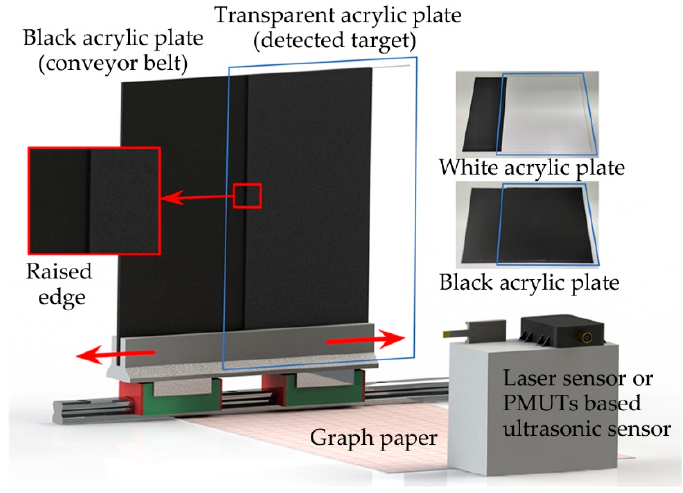
Figure 7. Dynamic experimental setup.